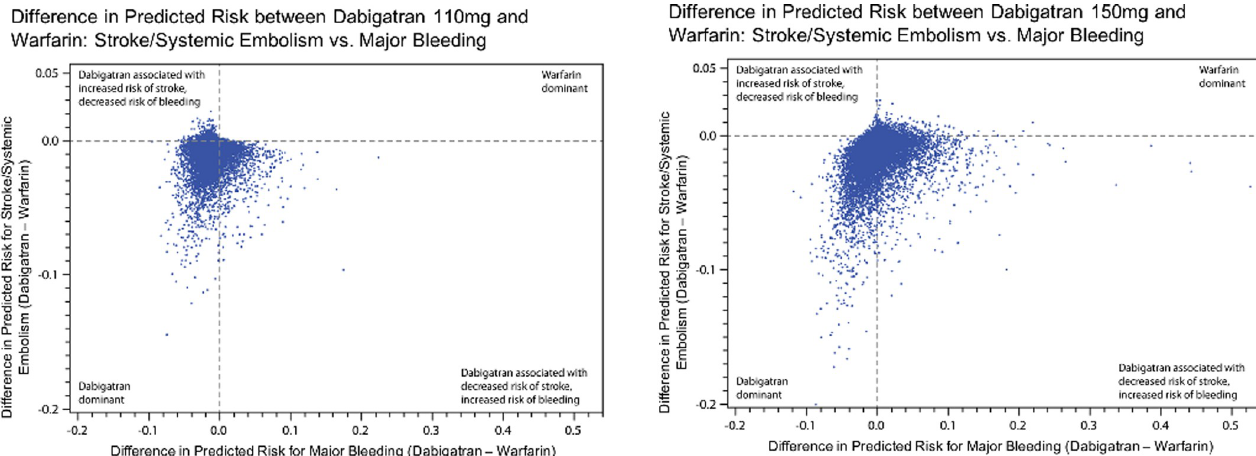
Fig 3. Scatter plot depicting each patient’s net predicted risk for stroke or systemic embolism and major bleeding. Panel A shows the plot comparing treatment with dabigatran 110mg versus warfarin, and Panel B compares dabigatran 150mg and warfarin. Each dot represents a patient, with the net predicted risk (warfarin minus dabigatran) of stroke or systemic embolism on the y-axis, and the net predicted risk (warfarin minus dabigatran) of major bleeding on the x-axis. The further left on the x-axis, the lower the patient’s risk of major bleeding with dabigatran, and the further down on the y-axis, the lower the patient’s risk of stroke or systemic